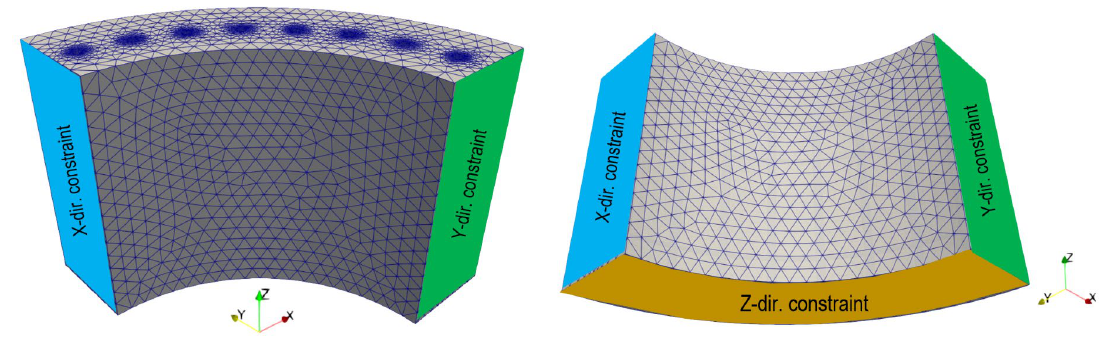
Figure 2. Three-dimensional finite element model of one quarter of the spun pile section. A zero-thickness element [36] was used to simulate the bond–slip behavior of the concrete and PC-bars in three (i.e., two transverse and one longitudinal) directions. The PC-bars were assumed to only slip longitudinally, and the occurrence of the slip was determined using a nonassociated flow rule and the hyperbolic Mohr–Coulomb plasticity model. The stress integration algorithm applied the tangent cutting plane method